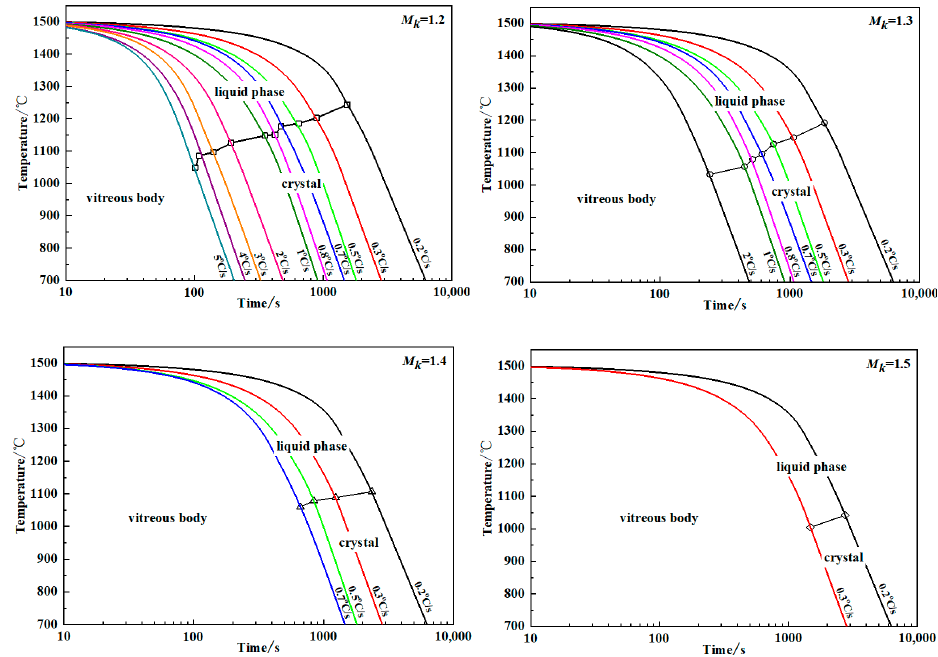
Figure 8. CCT curves of modified blast furnace slags with different M k values.